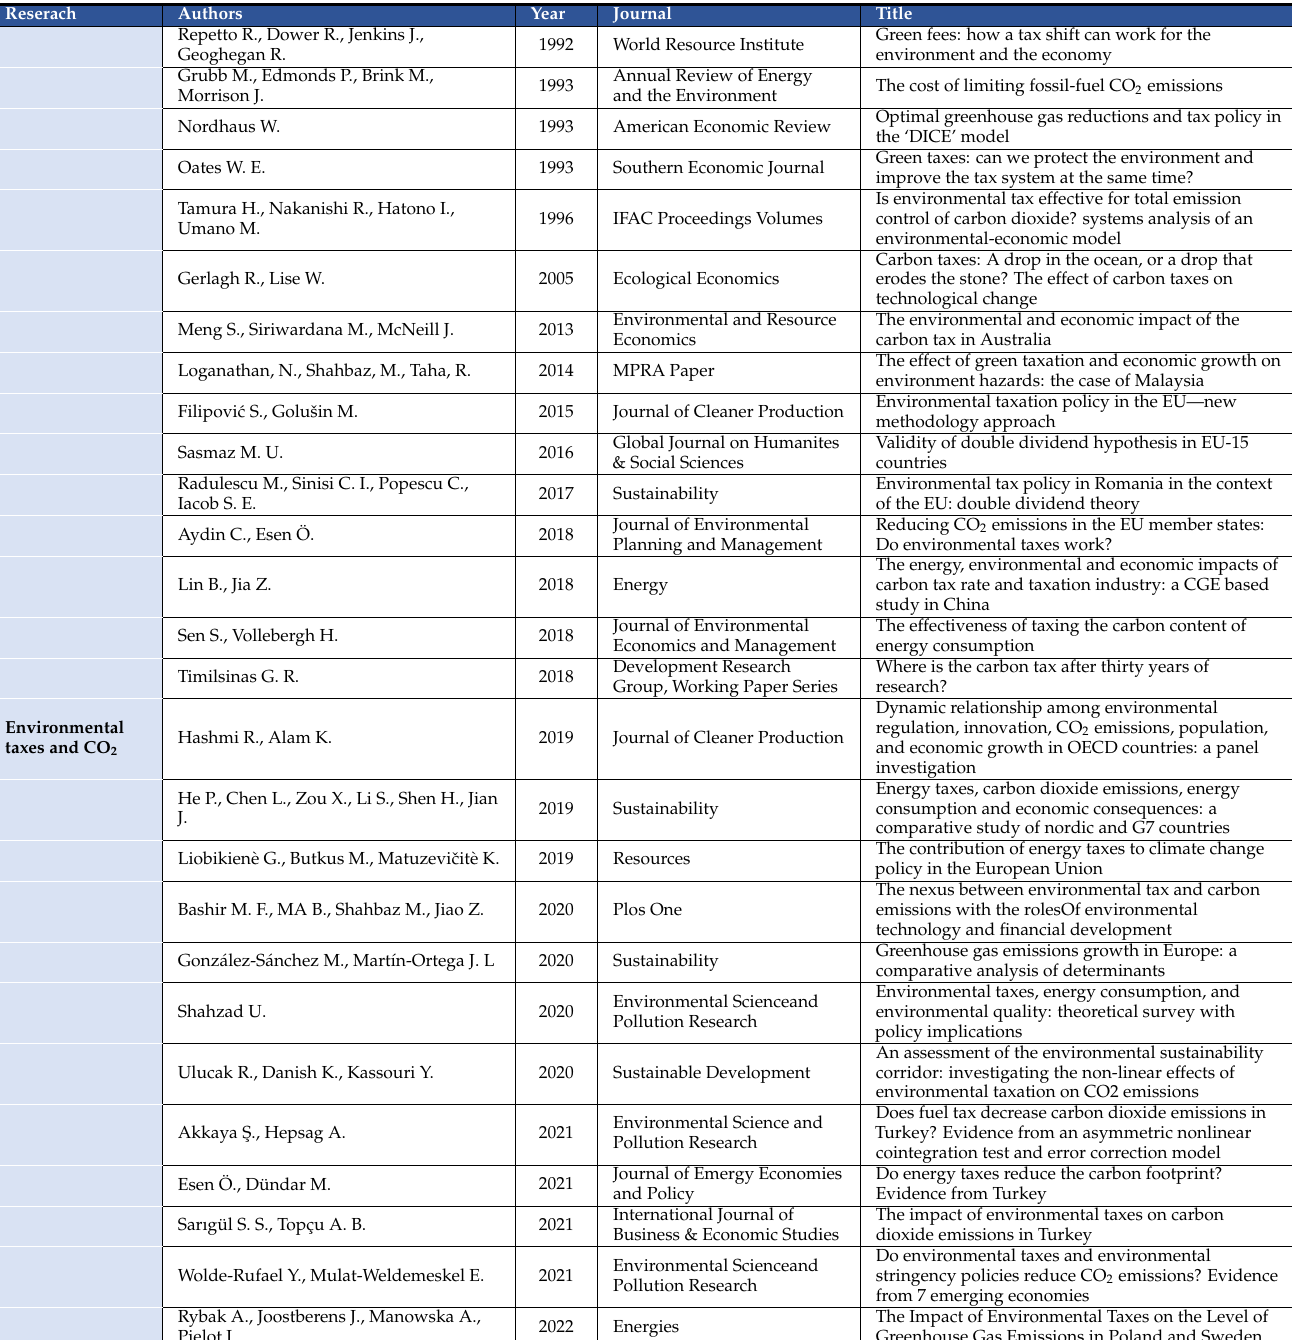
Table A1. Selected research on environmental taxes (1991–2021) (source: own